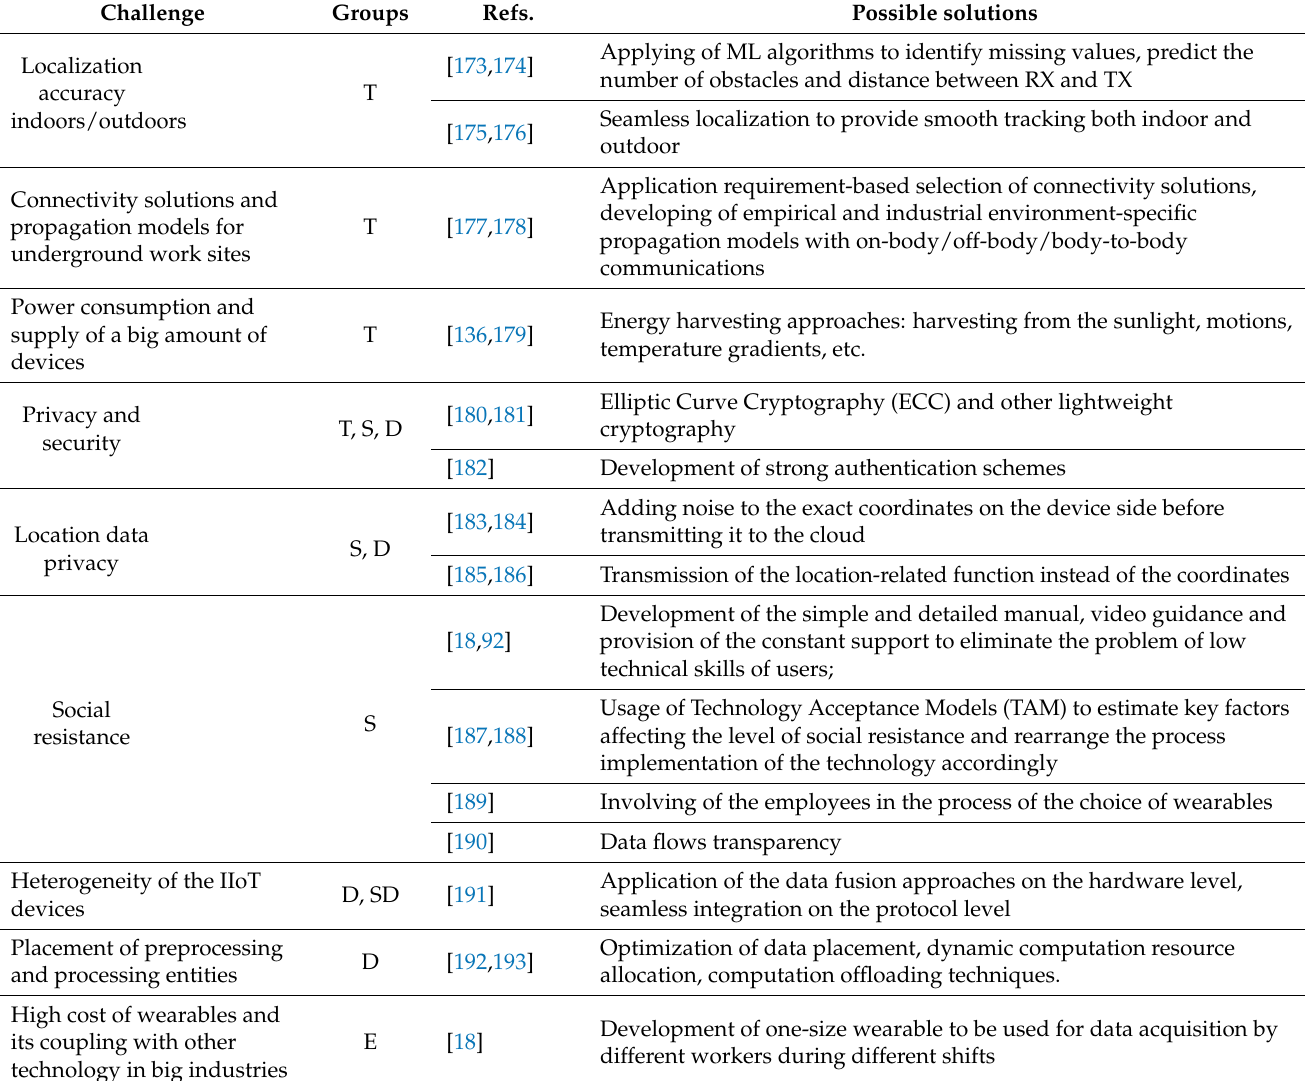
Table 7. Key challenges in the adoption of industrial